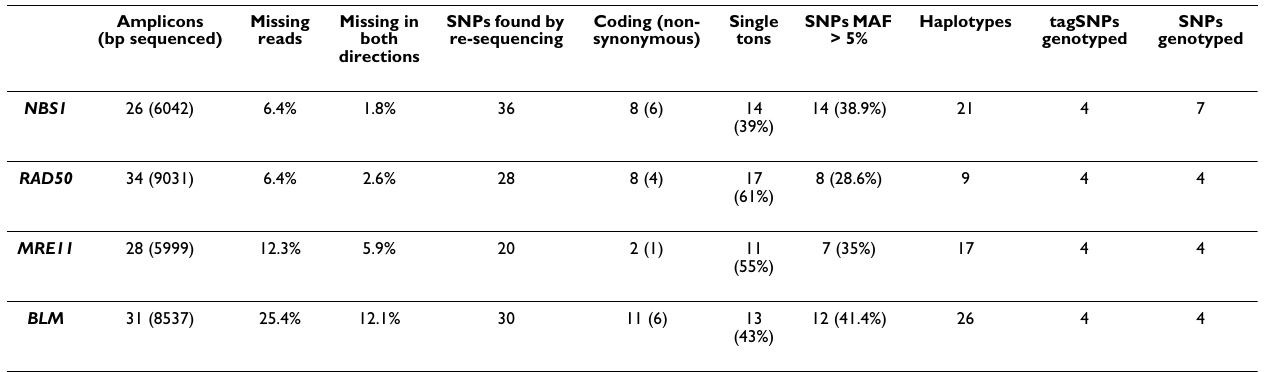
Table 2: Gene statistics summary. For NBS1 , 7 SNPs were genotyped - 4 chosen as tagSNPs and 3 chosen for functional interest. Amplicons (bp